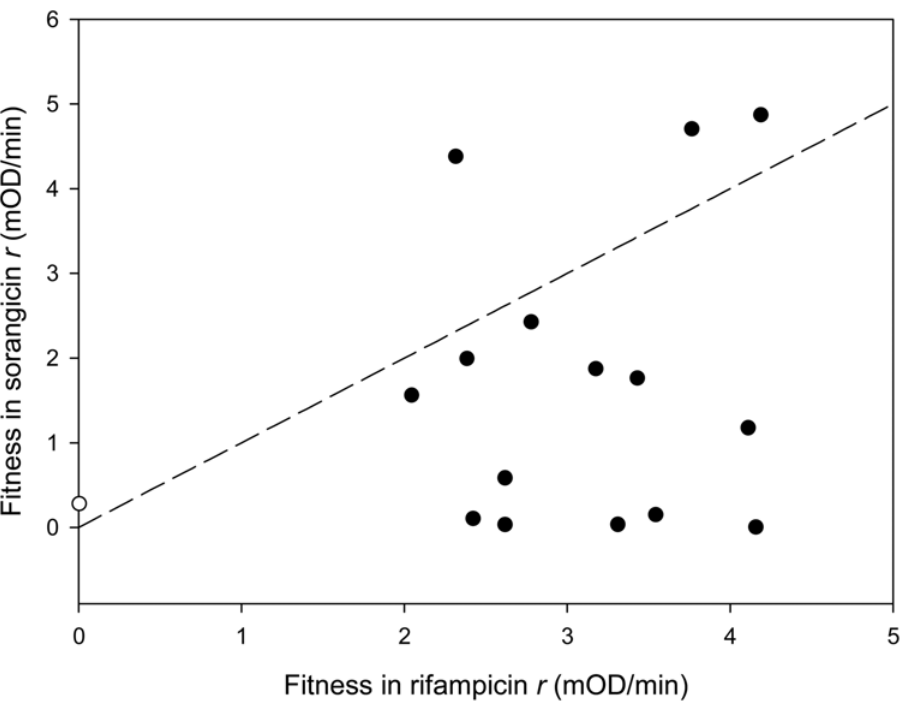
Figure 5. Fitness in the presence of sorangicin. This figure shows the fitness of beneficial mutations (filled symbols) and the ancestral clone (open symbol) at 64 mg/L rifampicin (n=18 replicates/genotype) and 20 mg/L sorangicin (n=6 replicates/genotype). The dashed line is a plot of y=x.